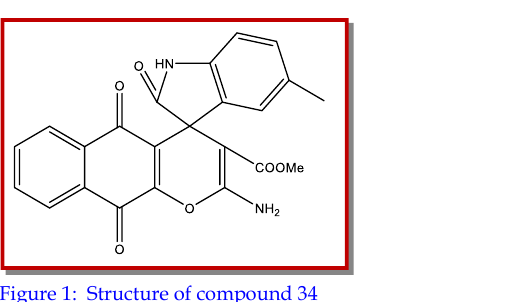
Figure 1: Structure of compound